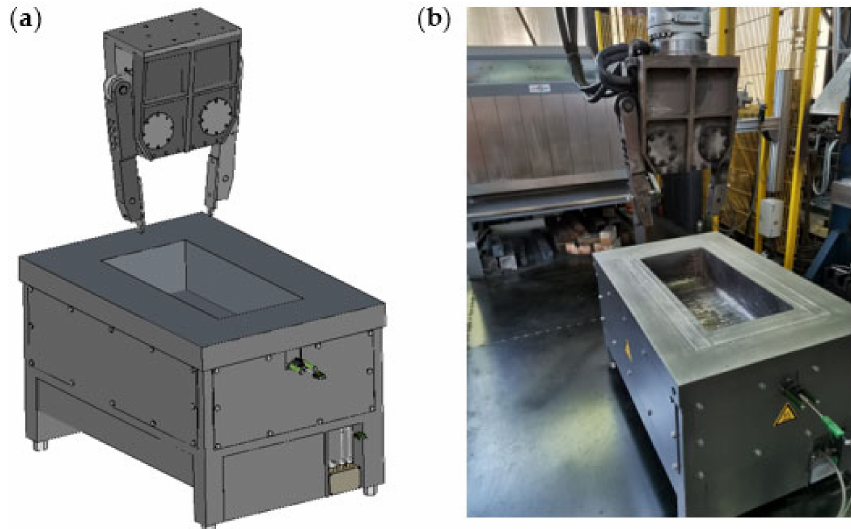
Figure 1. Experimental batch galvanising furnace with resistance heating in combination with a robotic arm KUKA: ( a ) Technical drawing; ( b ) Experimental set-up.